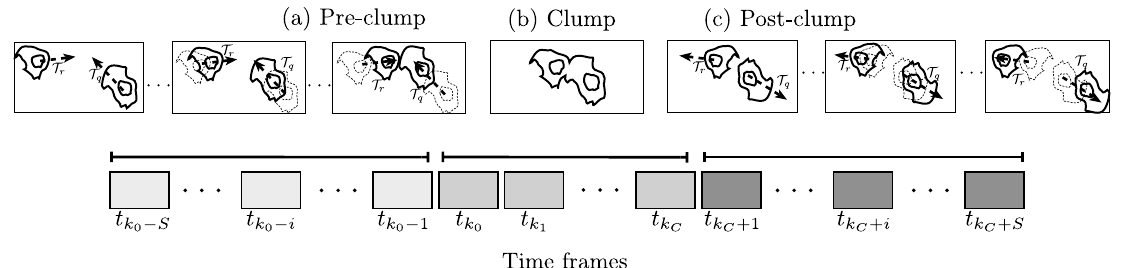
Figure 6. Diagram explaining the time frames chosen from tracks T r , T q for the analysis of direction change. The time frames chosen for the analysis are S frames before t k frames are selected, and schematics of the cells moving are shown for each stage.